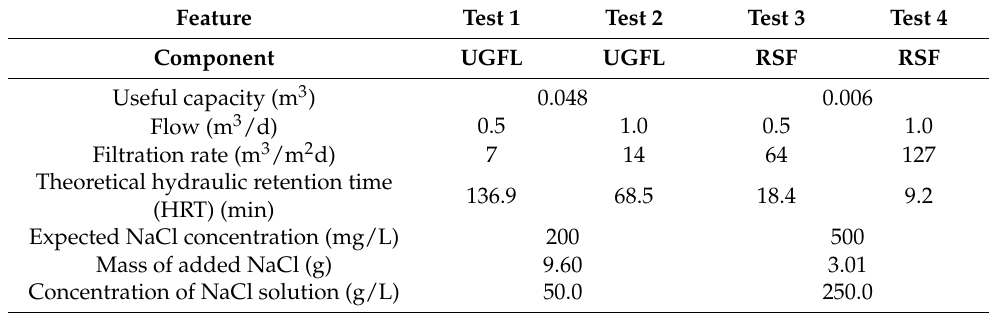
Table 2. Conditions for the conduct of tracer